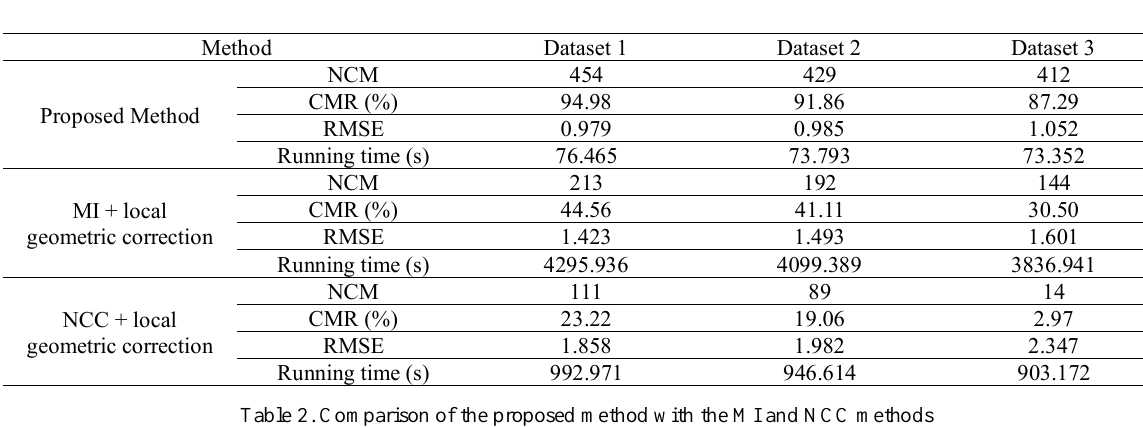
Table 1. Specifications of the test data